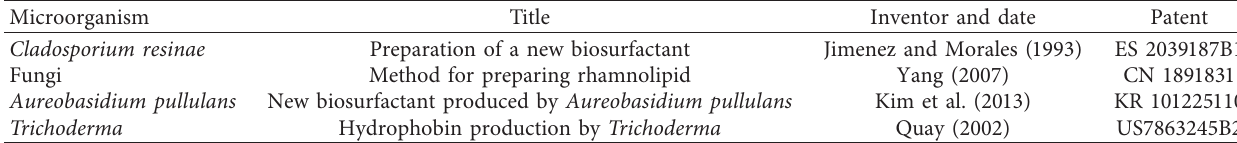
Table 4: Filamentous fungi producing biosurfactants deposited in the patent